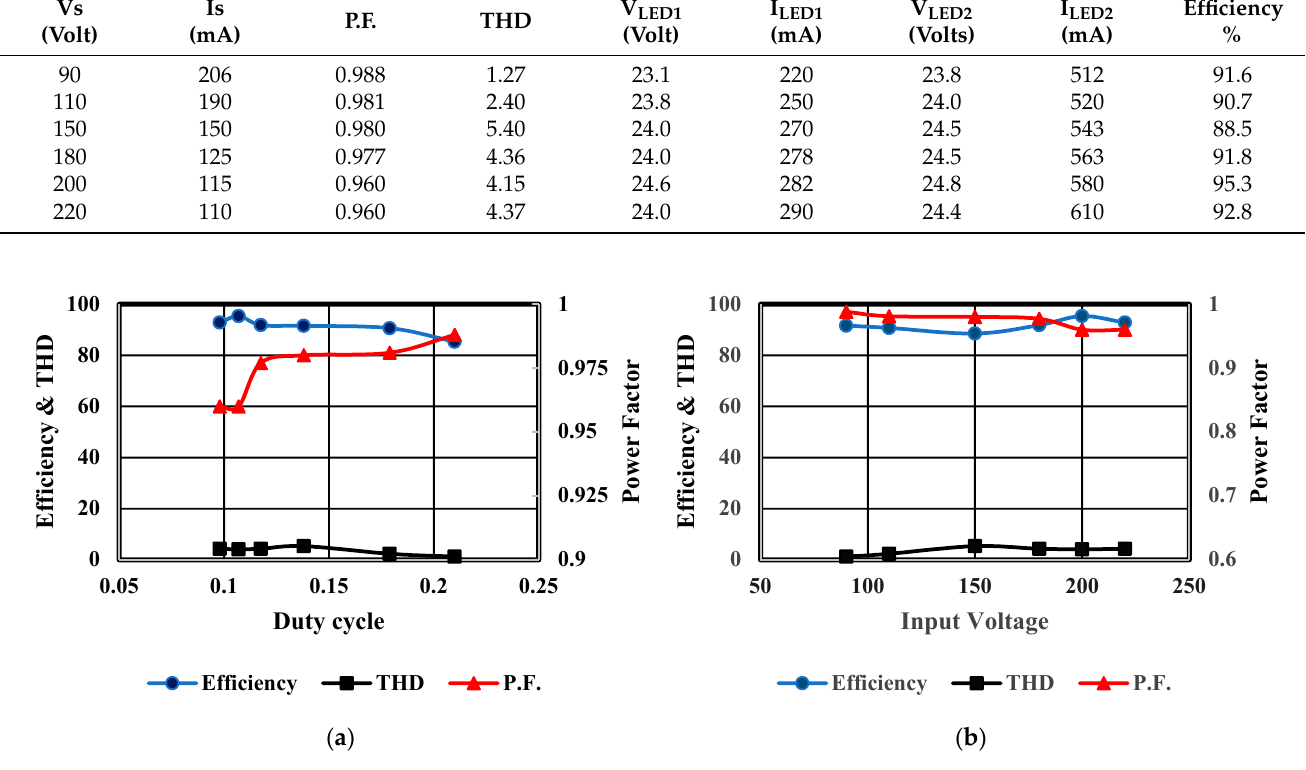
Figure 14. ( a ) THD, P.F., and efficiency vs. duty cycle graph; ( b ) THD, P.F., and efficiency vs. input voltage